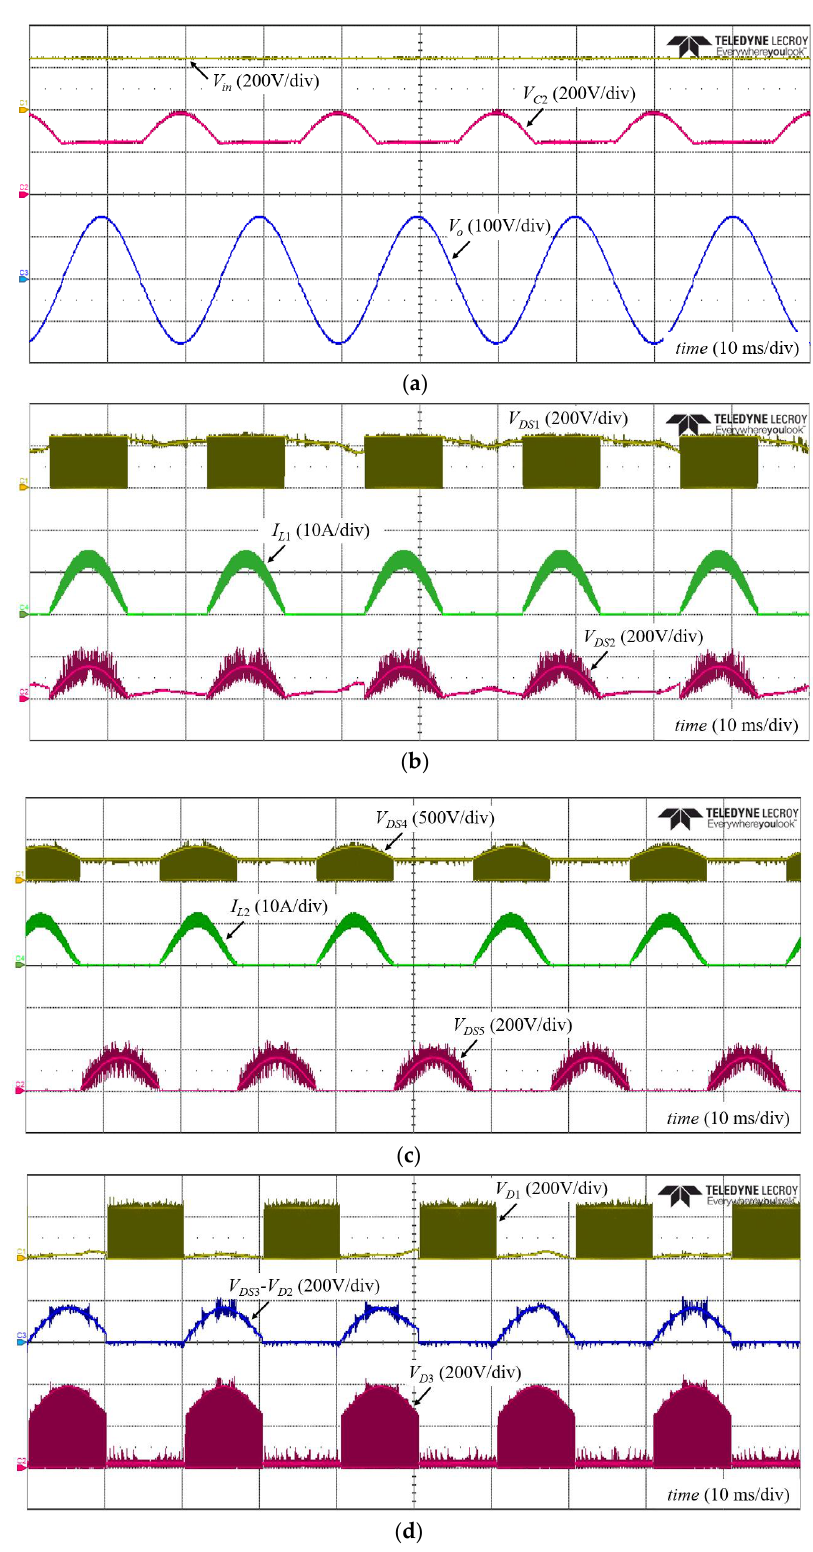
Figure 8. Experimental results with V in = 60 V. ( a ) the input, output and capacitor C 2 voltages, ( b ) the voltage stress on switches S 1 , S 2 , and the current of inductor L 1 , ( c ) the voltage stress on switches S 4 , S 5 , and the current of inductor L 2 , and ( d ) the voltage stress on diodes D 1 , D 2 , D 3 and the voltage stress on switch S 3 .